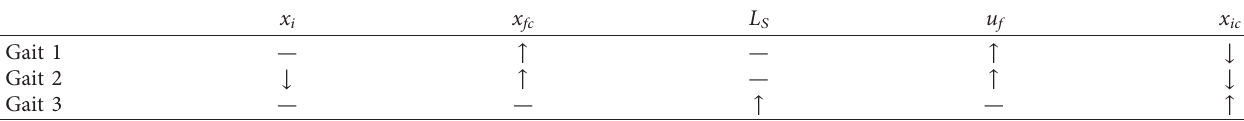
i , x fc , L S , u f , and x ic